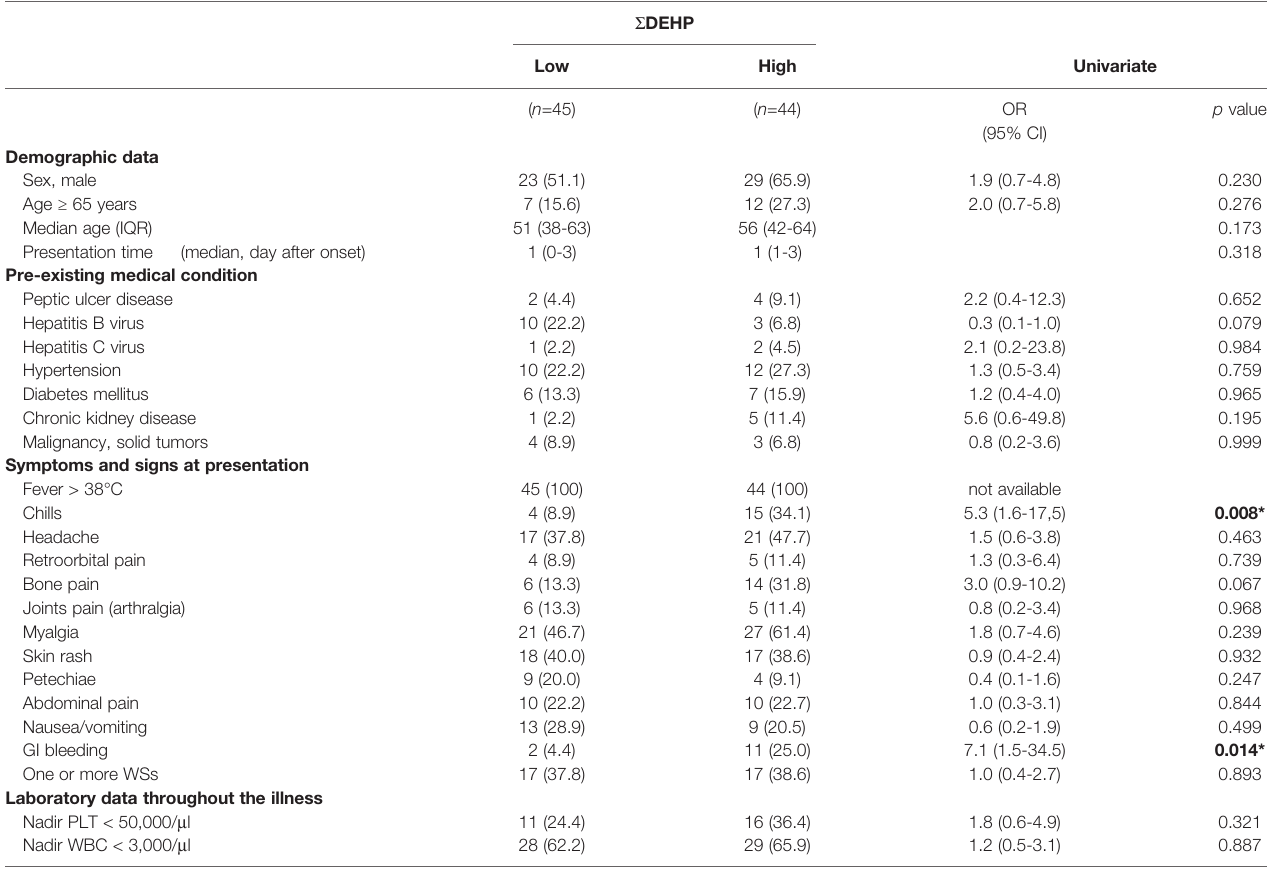
TABLE 1 | Demographic and clinical characteristics and laboratory data of patients with dengue virus infection.